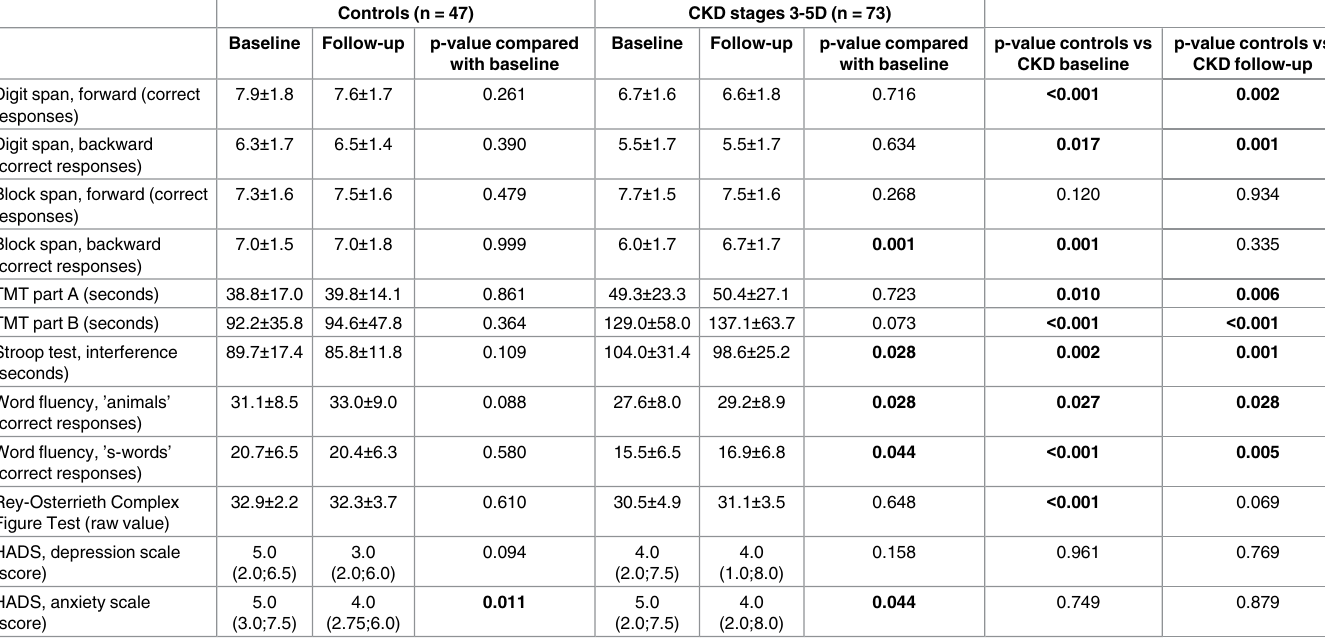
Table 2. Raw Values of Neuropsychological Tests of Control Patients and CKD patients at Baseline and Follow-up. Controls (n = 47) CKD stages 3-5D (n = 73) Baseline Follow-up p-value compared Baseline Follow-up p-value compared p-value controls vs p-value controls vs with baseline with baseline CKD baseline CKD follow-up Digit span, forward (correct responses)